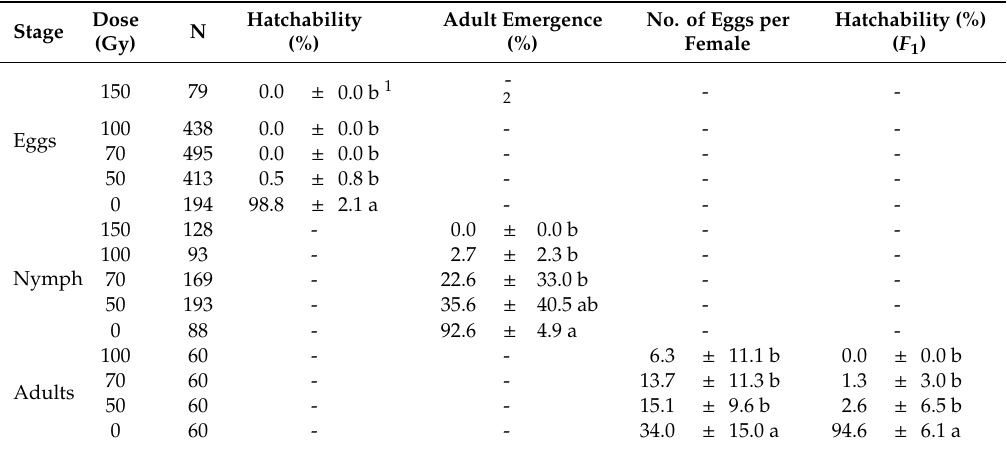
Table 1. E ff ect of electron beam irradiation on the hatchability, emergence, longevity, fecundity, and F 1 hatchability of Trialeurodes vaporariorum.